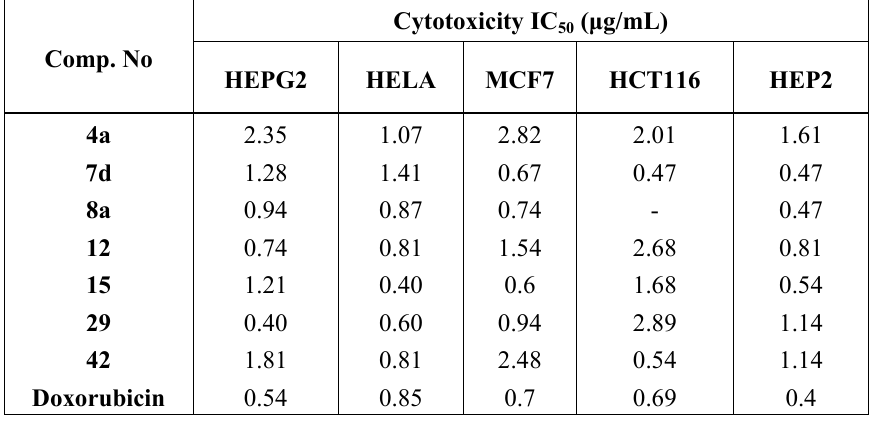
Table 3. Results of antitumor cytotoxicity for some synthesized